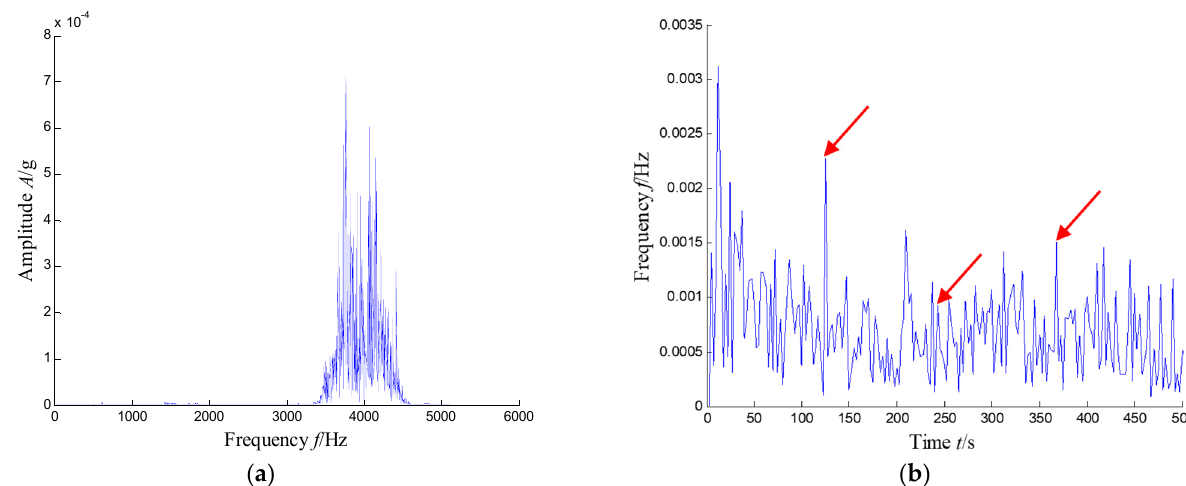
Figure 30. Extracted signal waveform.